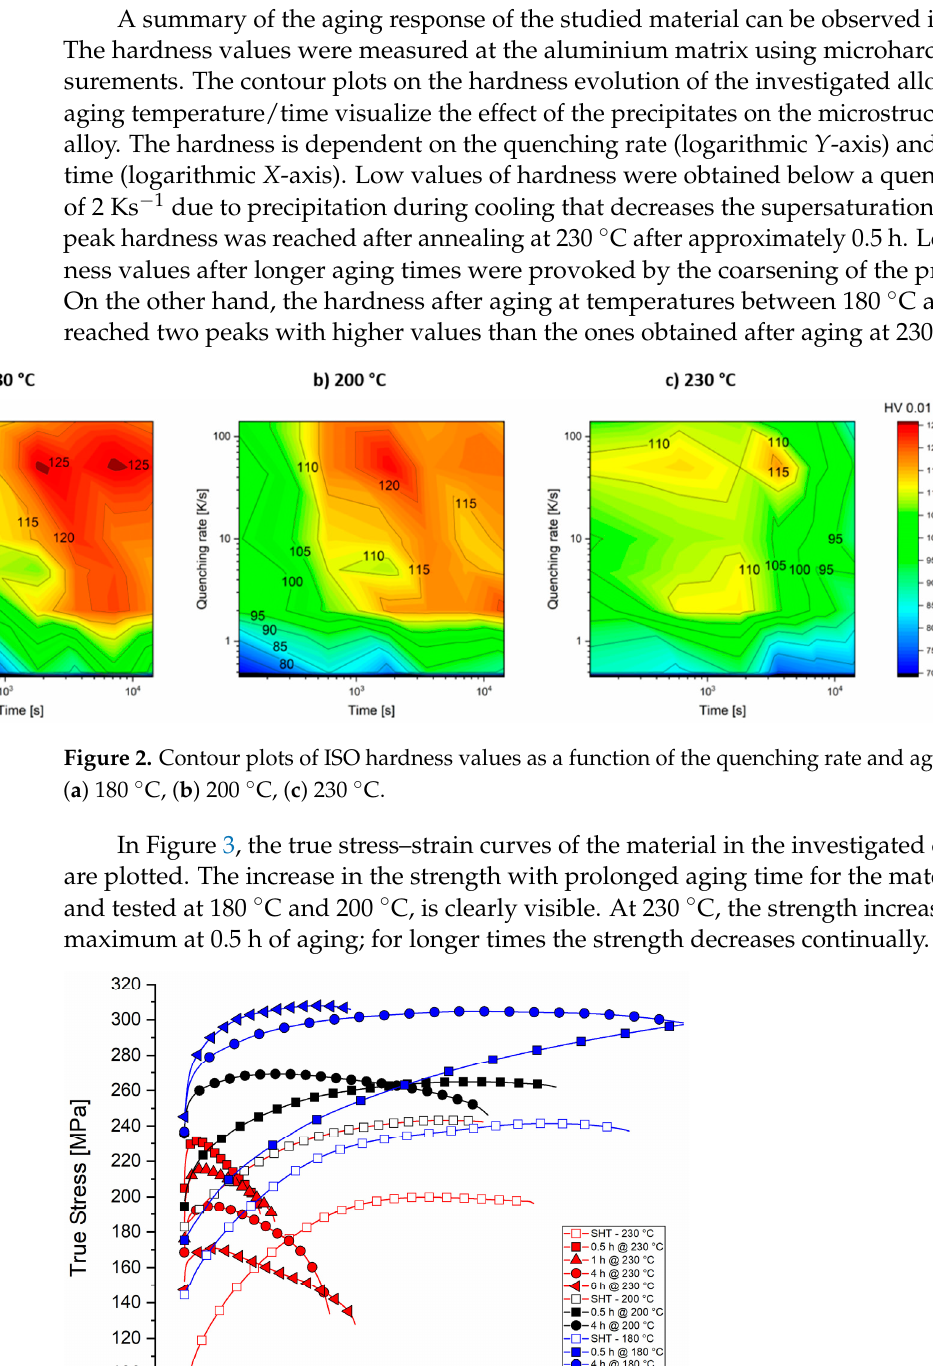
Figure 3. True stress–strain curves of the Al alloy in the conditions investigated in this